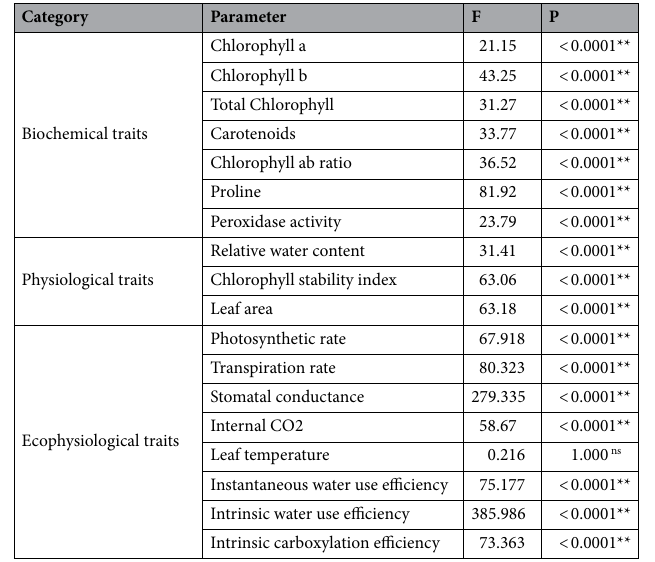
Table 2. Variance analysis (ANOVA) of biochemical parameters, physiological parameters and ecophysiological traits among teak seed sources. **Highly significant difference at p < 0.001 level of probability, and ns—no